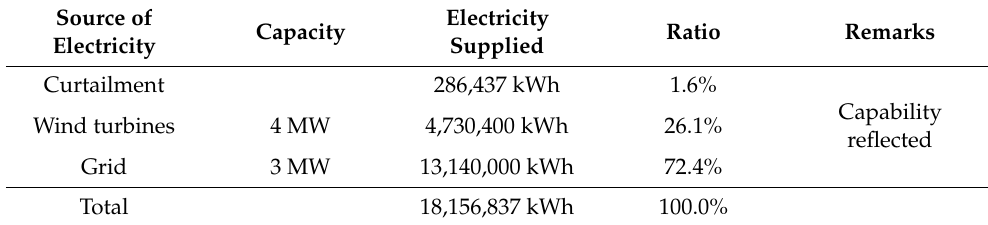
Table 38. The annual amount of electricity with the enhancement in grid capacity (Scenario